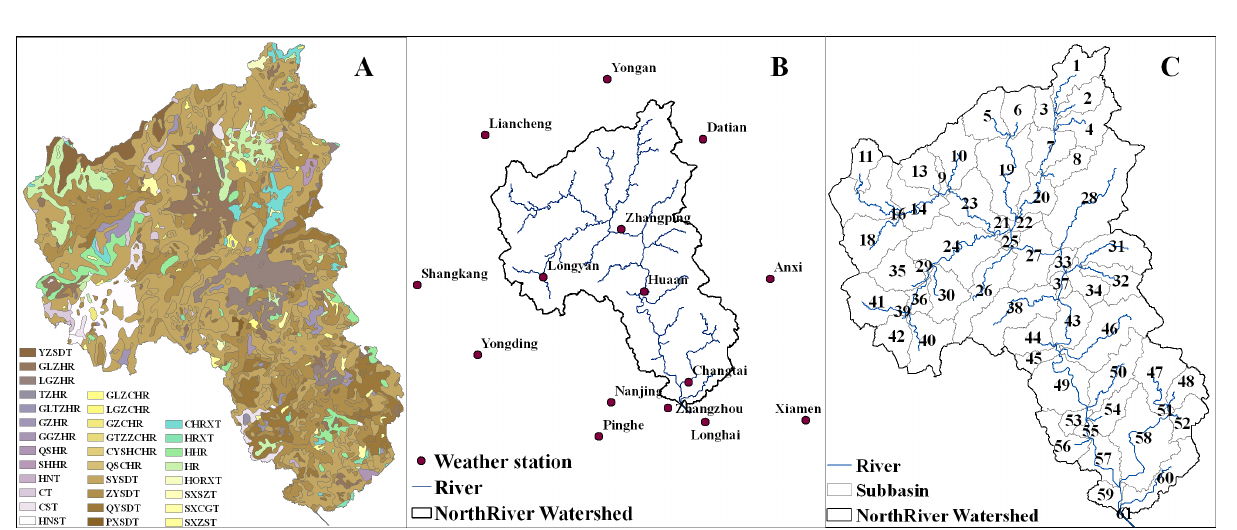
Table (.dbf and text) Climate stations Figure 2. Soil maps ( A ), weather station locations ( B ) and watershed delineation ( C ) in the